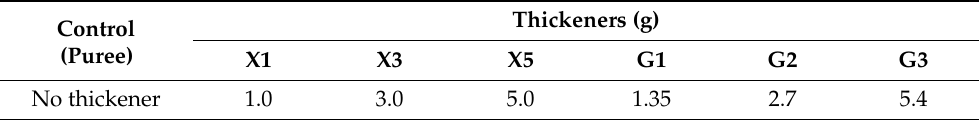
Table 2. Condition of thickeners added based on 100 g of the